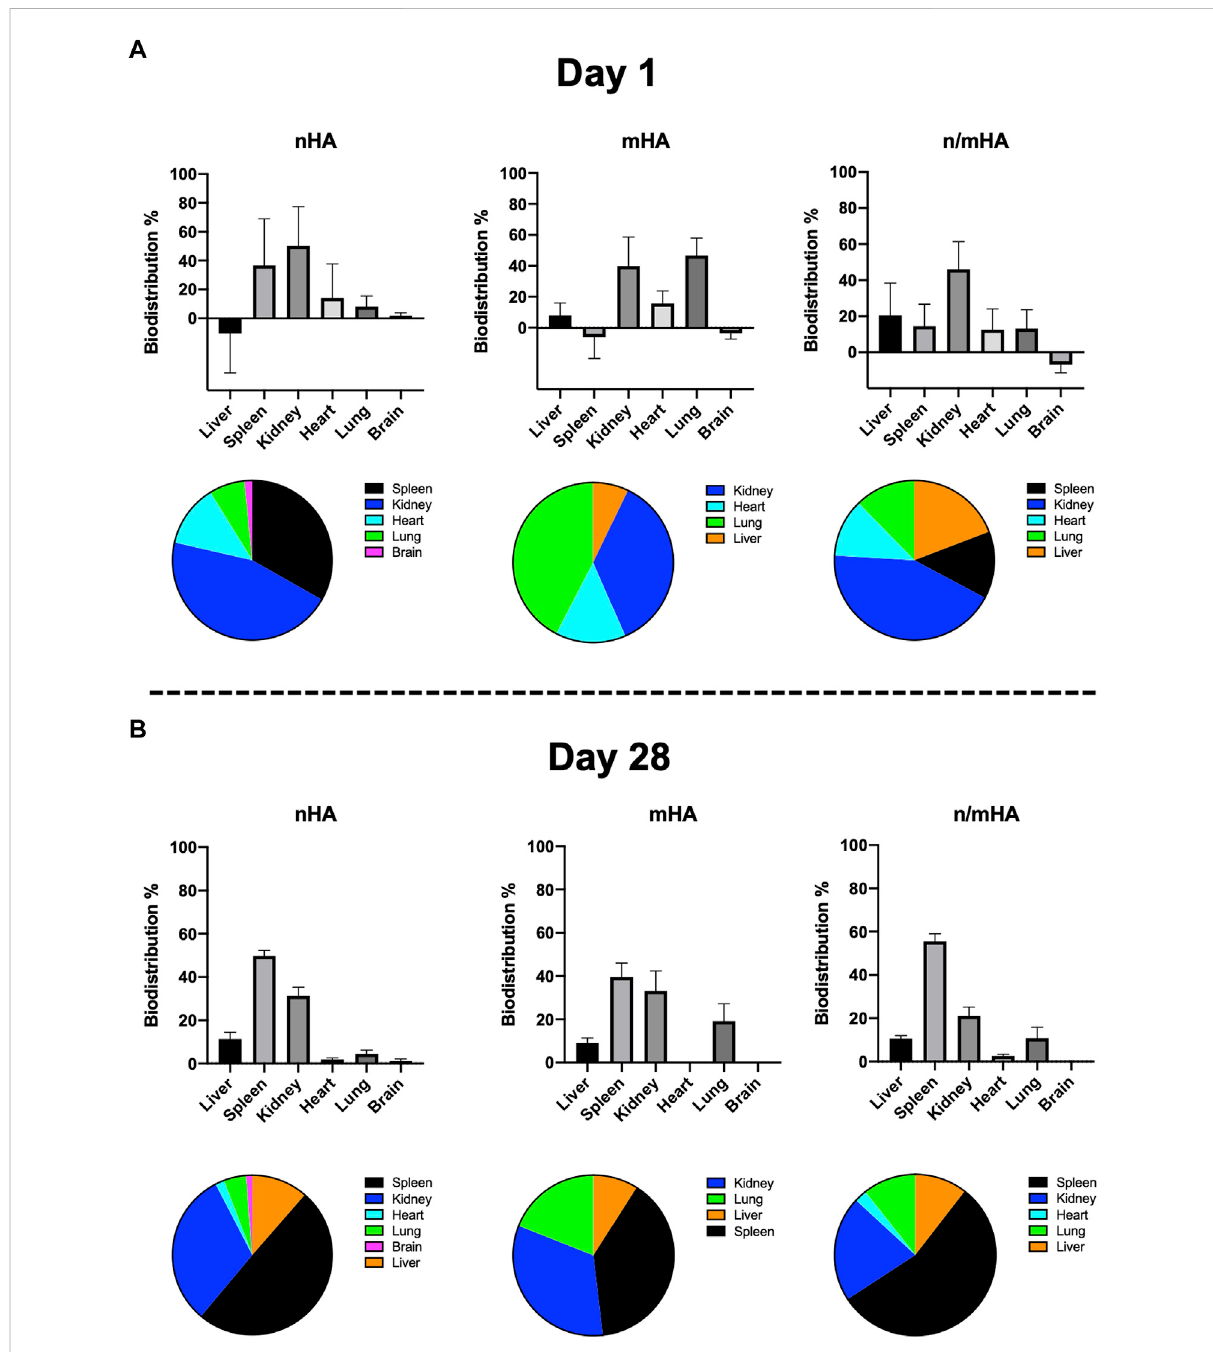
FIGURE 5 TheproportionofHAparticleswhich havemigrated tovital organsatanearlyandlate stage. (A) Showsthedistribution ofmigratedHAparticles in vital organs 1-day post-implantation. (B) Shows the distribution of migrated HA particles in vital organs 28-day